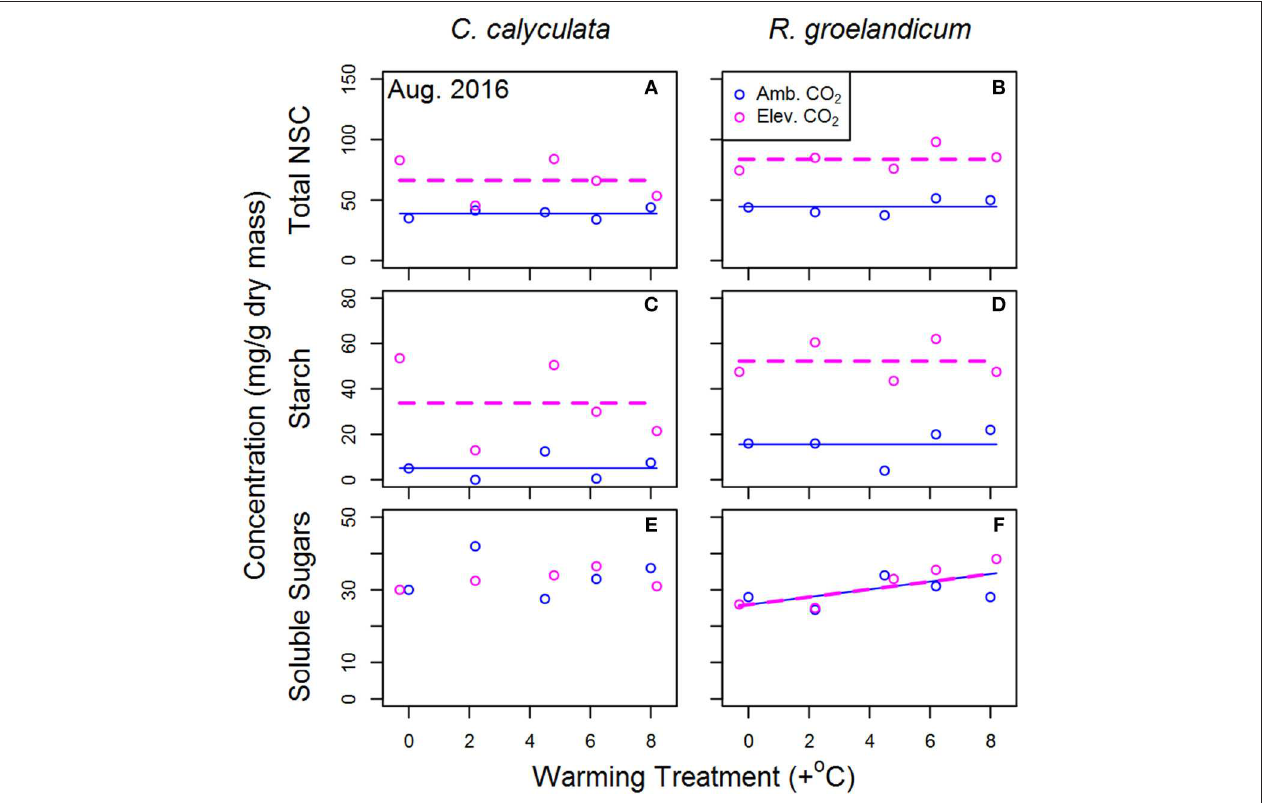
FIGURE 5 | Mean proportion of non-structural carbohydrates ( NSC ) by dry mass for mature leaves of two shrub species at the SPRUCE site in each plot. Warming treatments indicate mean growing season temperature (April–October 2016) difference at 1m canopy height, relative to the control chamber (Plot 6). Lines indicate fit of best model, as evaluated using Akaike Information Criterion corrected for sample size (AICc). Panels without lines have intercept-only best models as shown in Table 2 . Total non-structural carbohydrates (NSC; A,B ), starch (C,D) and soluble sugars (sucrose and fructose; E,F ).